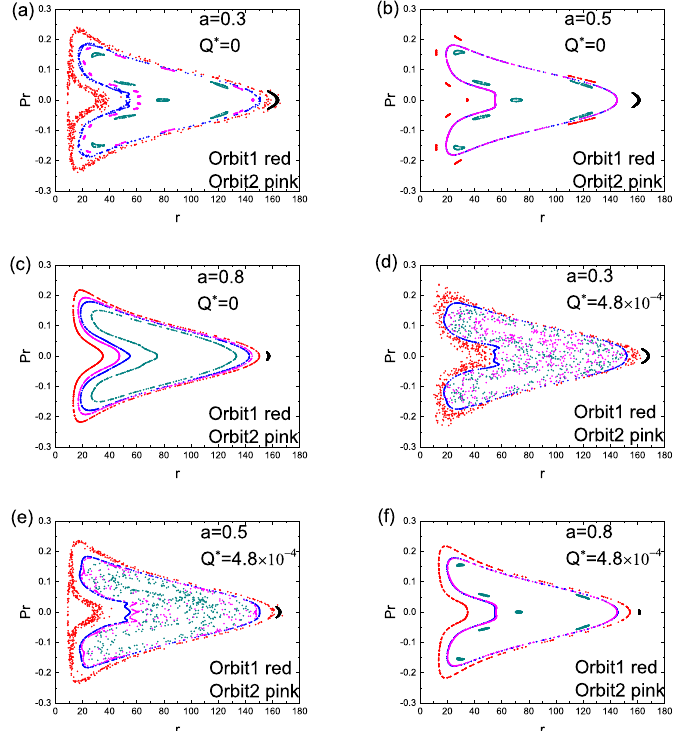
Figure 8. Poincaré sections. The parameters are E = 0.995, L = 4.6, and B ∗ = 0.0008. Orbits 1 and 2 have their initial separations r = 35 and r = 145, respectively. The initial separations are r = 15 for the black orbit, r = 55 for the blue orbit, and r = 75 for the green orbit. ( a – c ) have the same spins a = 0 but different charge parameters Q*. ( d – f ) have the same spins a = 0.00048 but different charge parameters